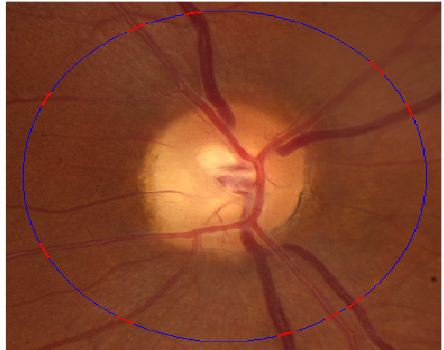
Fig. 11. Color retinal image with circular pro¯le marked in blue and small curved portions in